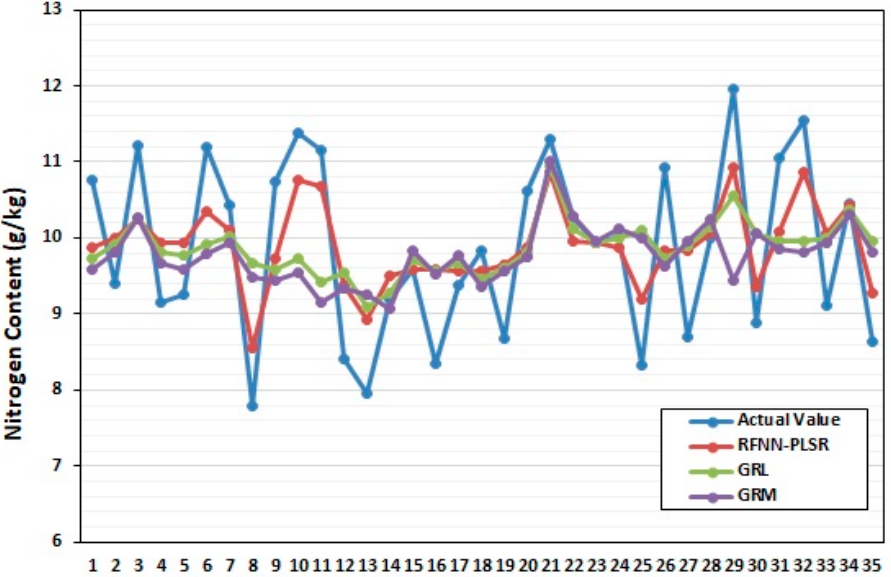
Figure 4. Distribution interval of pixel points in different stages in the G channel.